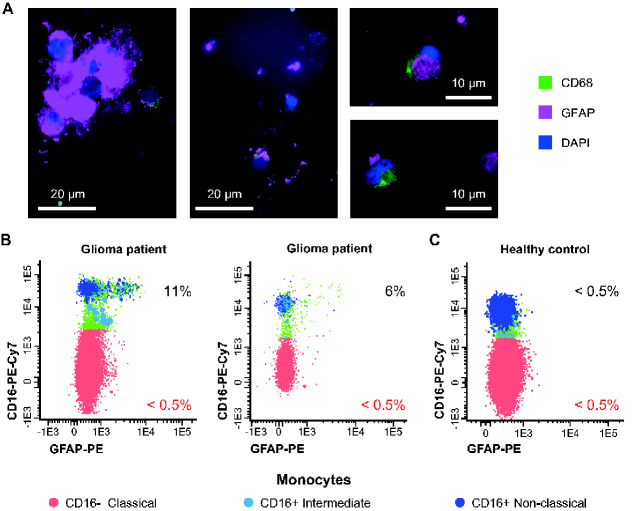

Detection of GFAP+ macrophages in brain tissue and in monocytes from patients suspected of glioma. (A) Dissociated glioma tissue contains CD68+ (green) and GFAP+ (magenta) cells. (B) Flow cytometric dot plots of blood monocytes from two patients suspected of glioma lesions and their GFAP expression levels. (C) Flow cytometric dot plot of GFAP expression in monocyte subsets in a representative example of a healthy control. White bar represents scale of the microscopy images. Percentage of GFAP+ cells (B, C). Dot plots show classical (red), intermediate (light blue) and non-classical (dark blue) monocytes.